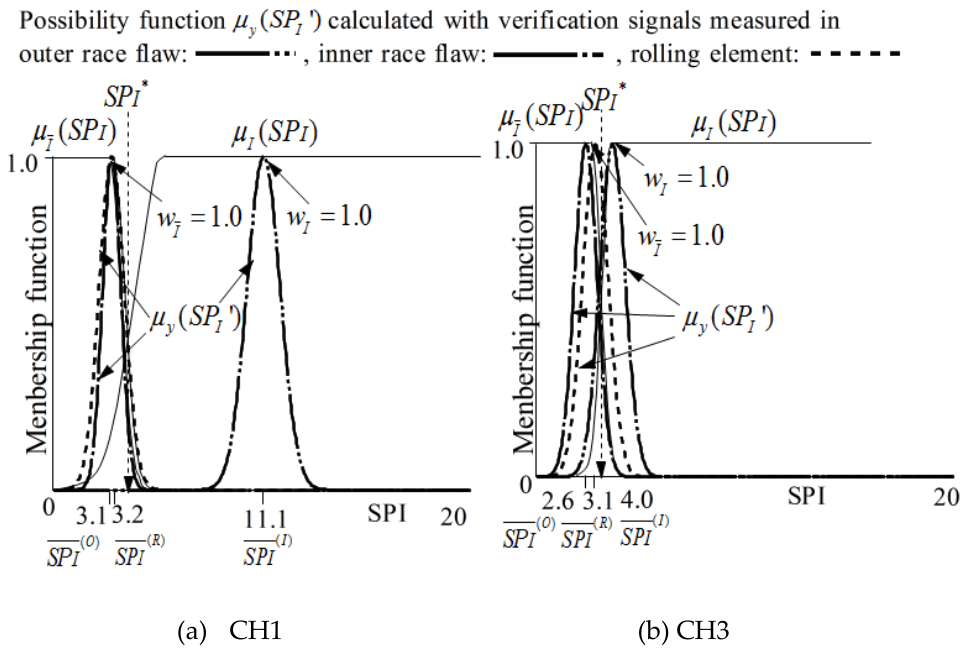
Figure 11. 𝜇 I (𝑆𝑃 𝐼 ) , 𝜇 I̅ (𝑆𝑃 𝐼 ) , and 𝜇 𝑦 (SPO’) for the judgement of inner race flaw . ( SP ) , and µ y (SPO’) for the judgement of inner race flaw. Figure 11. µ I ( SP I ) , µ I I